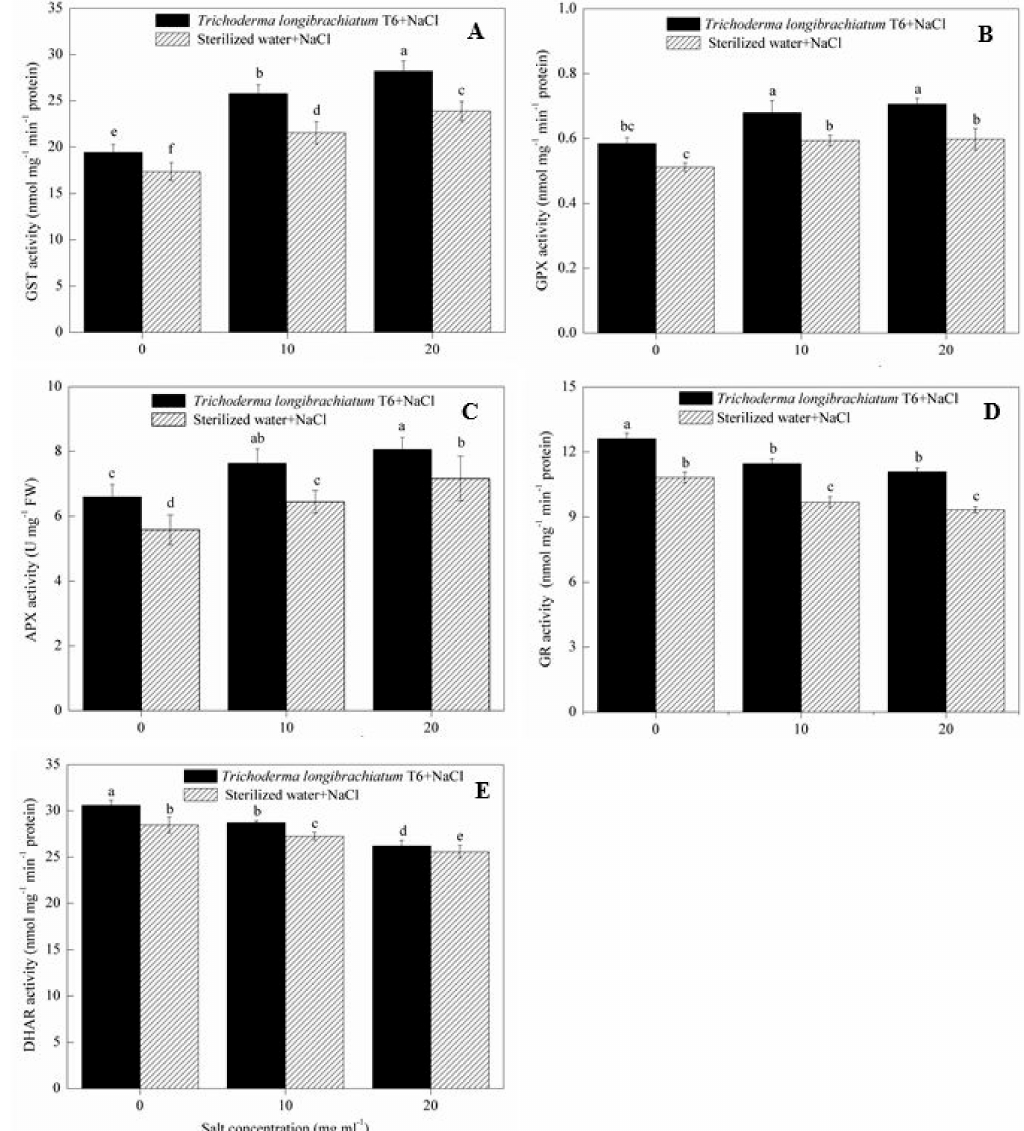
Figure 2. E ff ect of Trichoderma longibrachiatum T6 on the activity of ( A ) GST, ( B ) GPX, ( C ) APX, ( D ) GR and ( E ) DHAR in wheat seedling leaves under salt stress. The line bars represent the standard errors of the means. Di ff erent letters denote significant di ff erence at the p < 0.05 level by Duncan’s new multiple range test (n = 12). The treatments are detailed in the footnote of Table